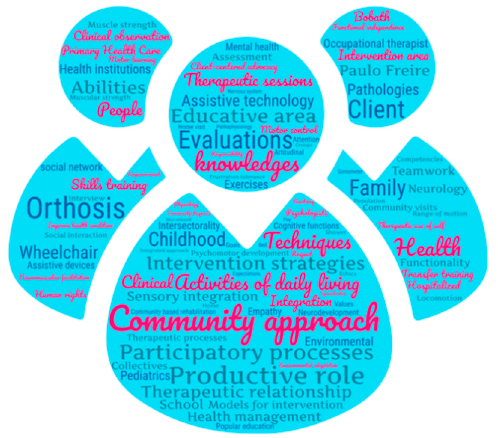
Figure 2. Word cloud of interviewee discourse. Random visualization of the 100 most frequent words and phrases in participants’ discourse. The size of each word is proportional to the number of times it was counted in the text.